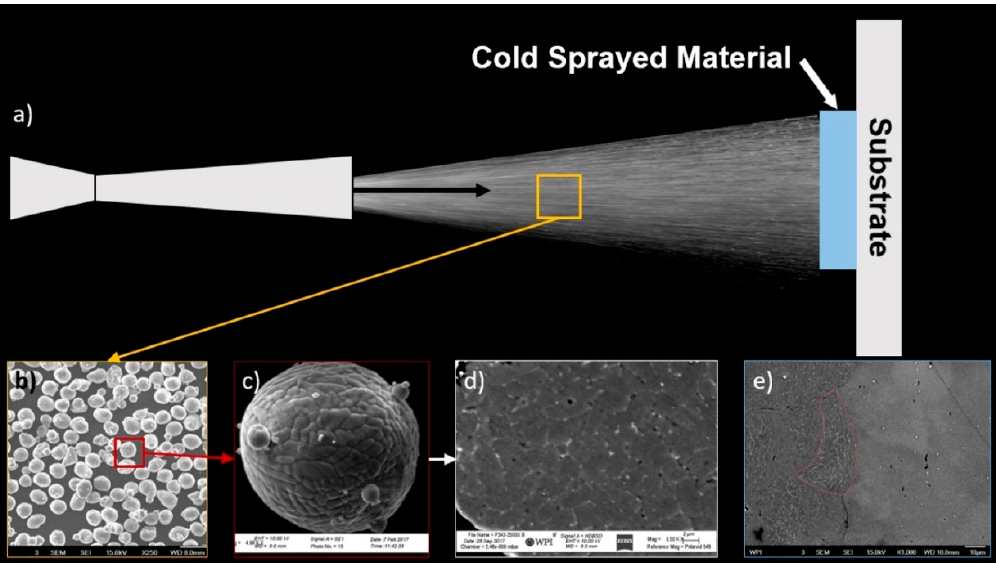
Figure 1. Cold spray process depiction with gas-atomized Al 6061 feedstock. ( a ) is a schematic overview of the cold spray process; ( b ) presents an SEM micrograph of the powder; ( c ) is an SEM micrograph of the surface of a single particle; ( d ) illustrates a SEM micrograph showing the internal microstructure of a single particle following cross-sectional preparation; and ( e ) captures a SEM micrograph showing the microstructure at the cold sprayed particle–substrate interface.